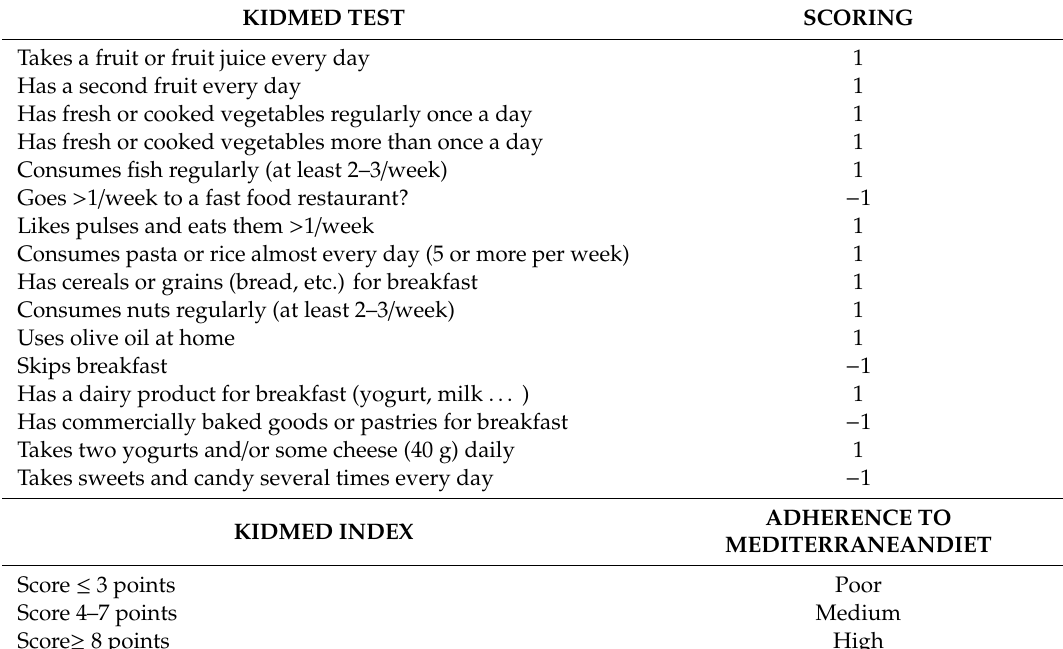
Table 1. Mediterranean Diet Quality Index for Children and Adolescents (KIDMED) test to assess Mediterranean diet adherence